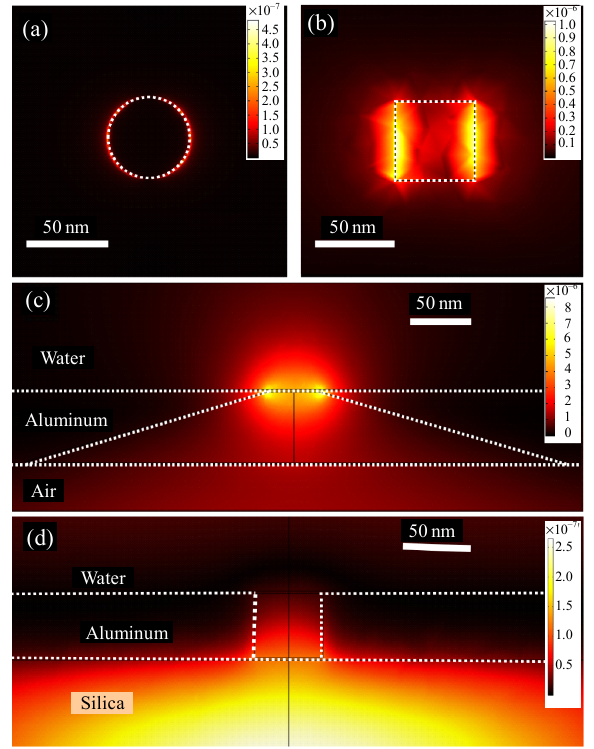
Fig. 4 Intensity profile of the electric field at z = 0: (a) conical morphology and (b) pyramidal morphology; (c) electric field profile of a near-field spot with the width of 50 nm at the apex and a height of 100 nm; (d) electric- field profile of a ZMW with a width of 50 nm and a height of 100